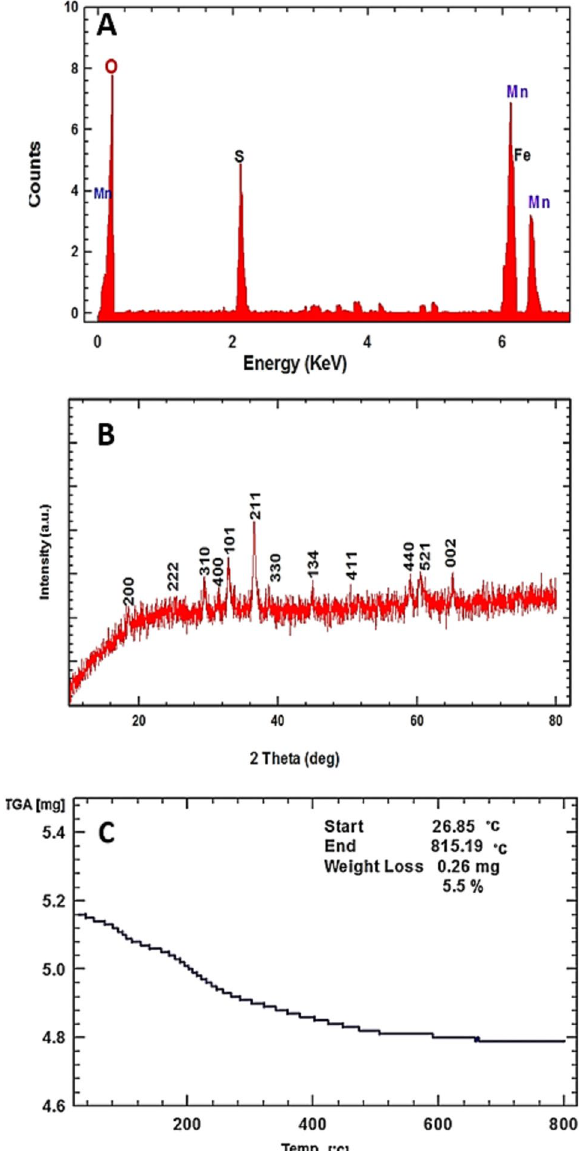
Figure 3. Characterization of fungus-fabricated MnO NPs using endophytic Trichoderma virens strain EG92 extract via EDX analysis ( A ), TGA thermal profile ( B ), and XRD analysis ( C